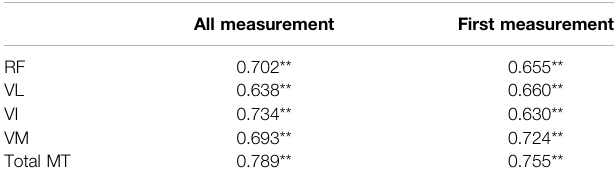
TABLE 3 | Correlation between MV and MT. All measurement First